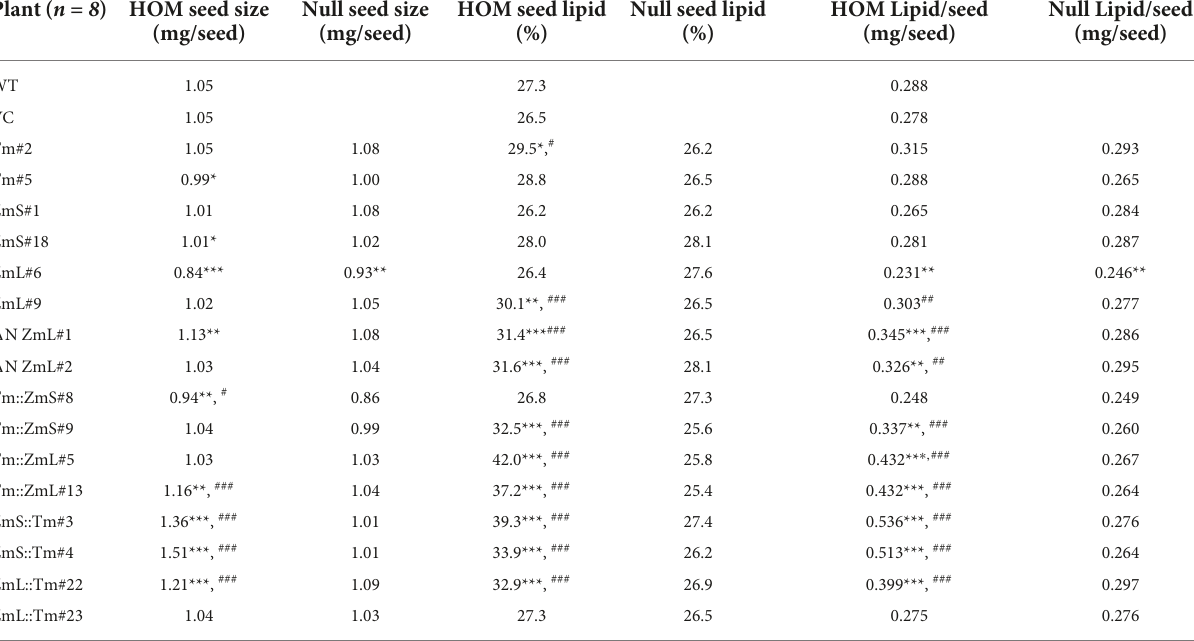
TABLE 2 Comparison of seed weight (mg), seed lipid content (% DW), and mg lipid per seed in wild-type (WT) and vector control (VC) as well as individual lines of homozygous (HOM) and respective null sibling Camelina sativa seeds from plants that had been transformed with either a full length DGAT1, a (cid:49) N ZmL or a chimeric